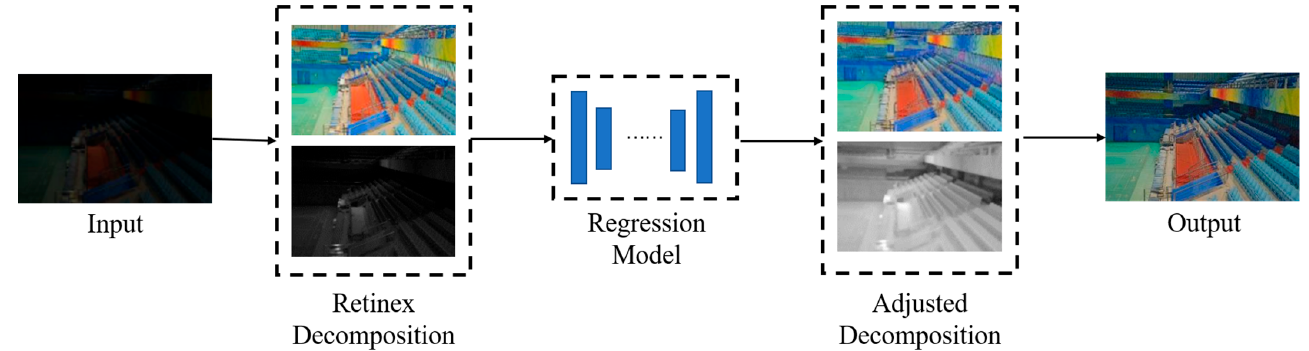
Figure 2. Flowchart of the RetinexNet algorithm. There are three parts: decomposition, adjustment, and reconstruction.